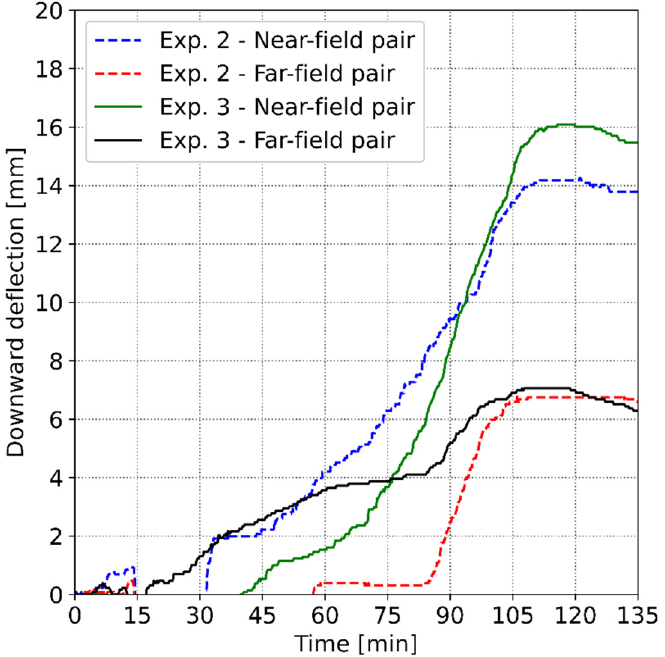
Figure 17. Mid-span downward deflection for each CLT slab pair in Experiments 2 and 3.